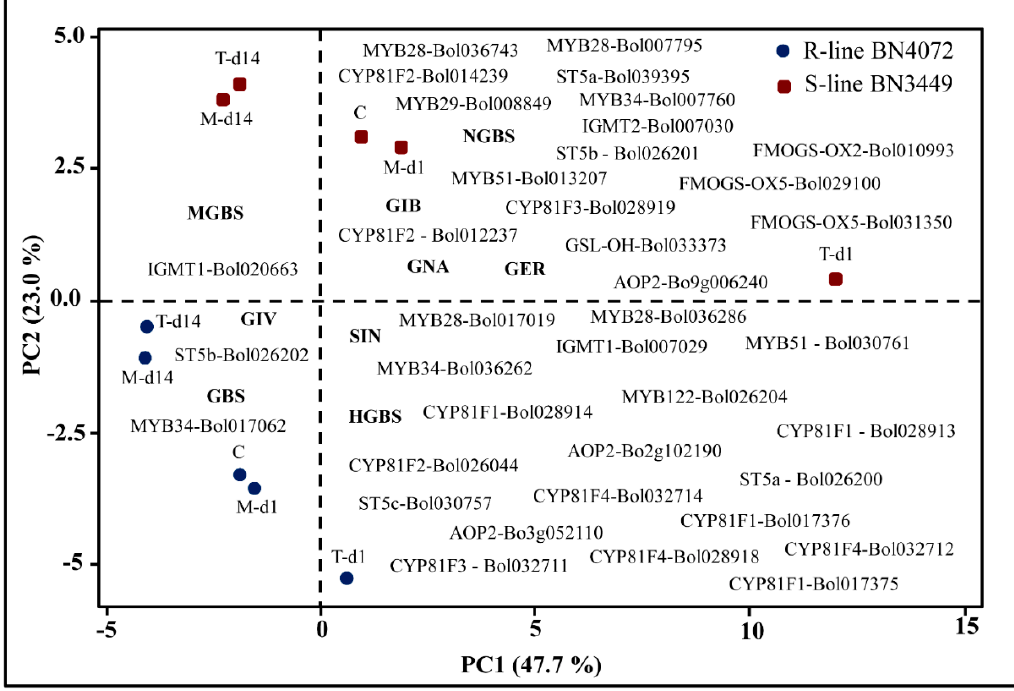
Figure 6. Biplot of cabbage ringspot R and S lines, glucosinolate components, and responses of glucosinolate pathway genes (denoted within figure) as determined by principle component analysis (PCA). Red squares denote the mean PC scores of the R line BN4072, and blue circles denote the mean PC scores of S line BN3449. Mycosphaerella brassicicola treatments indicated by C: Control; M-d1: Mock